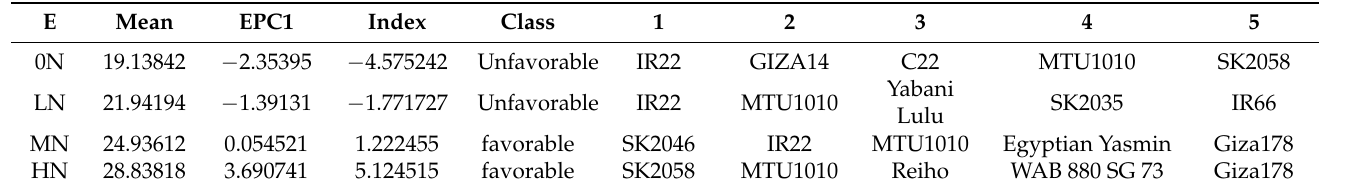
Table 1. AMMI analysis based on GY means for genotypic performance and N environment EPC1 value and the 5 top ranking genotypes for each N